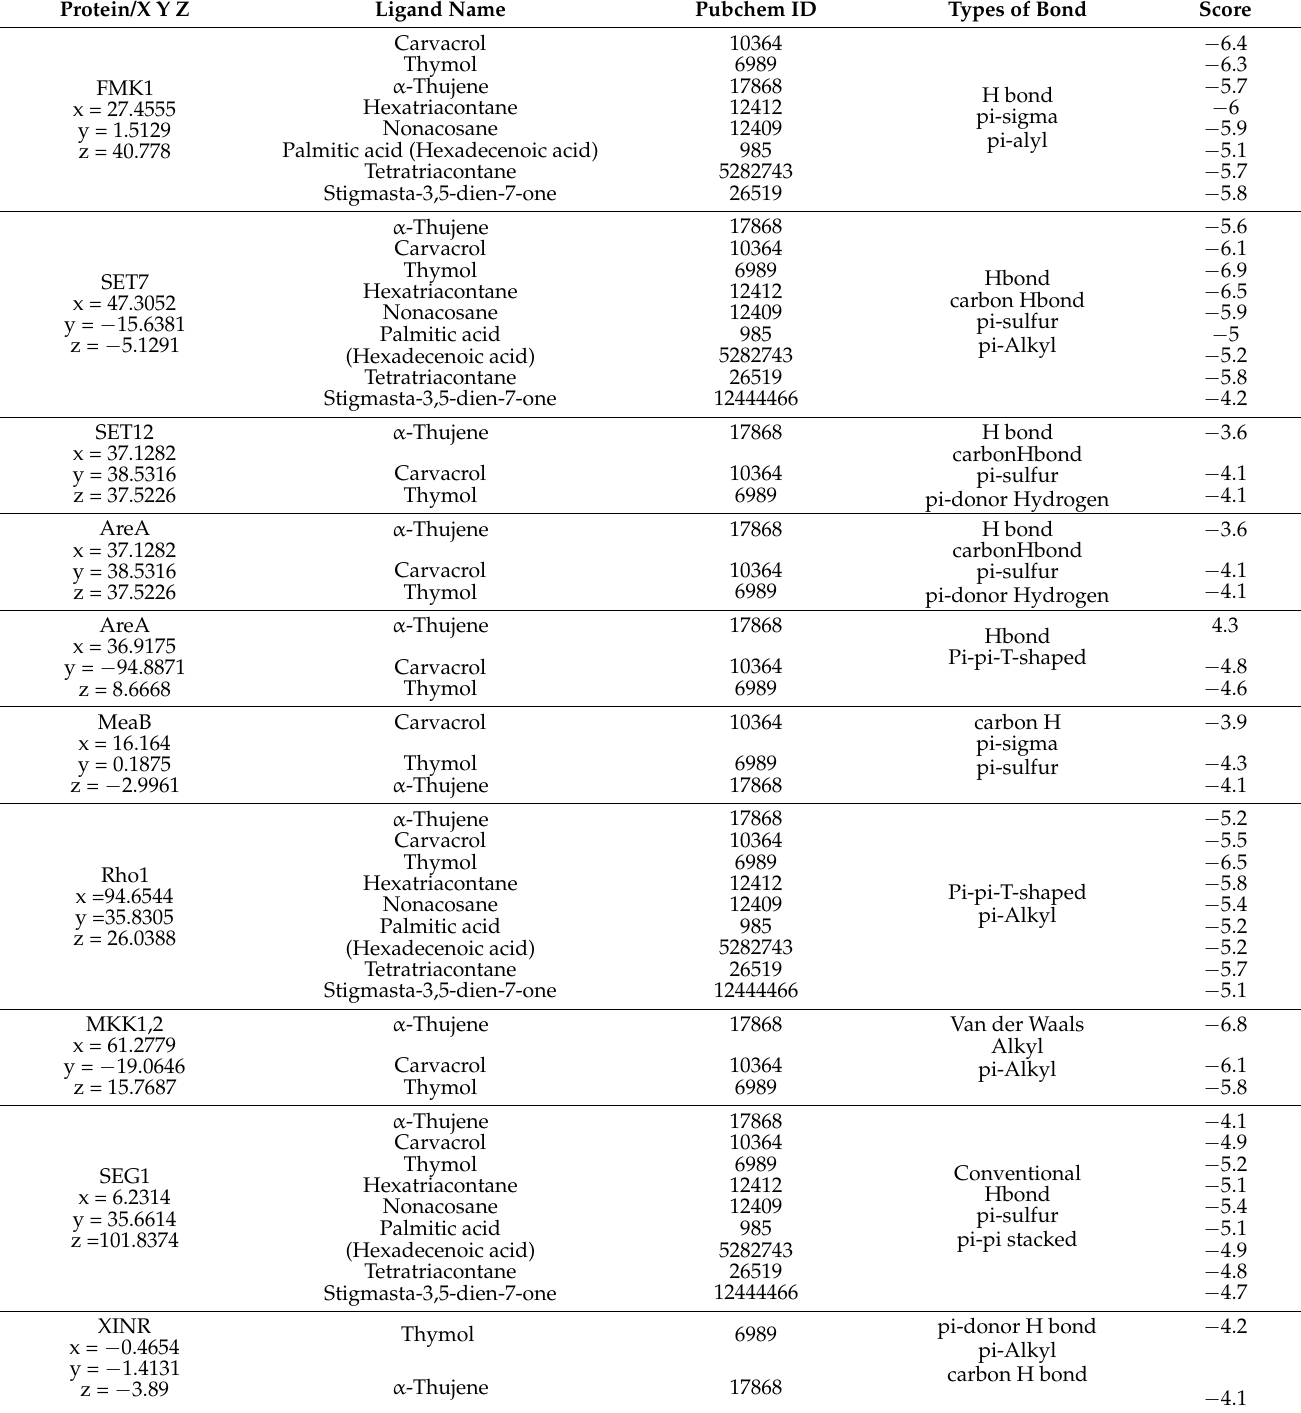
Table 5. Effects of plant phytochemical compounds, essential oils, and extracts on the F. oxysporum virulence proteins according to the docking